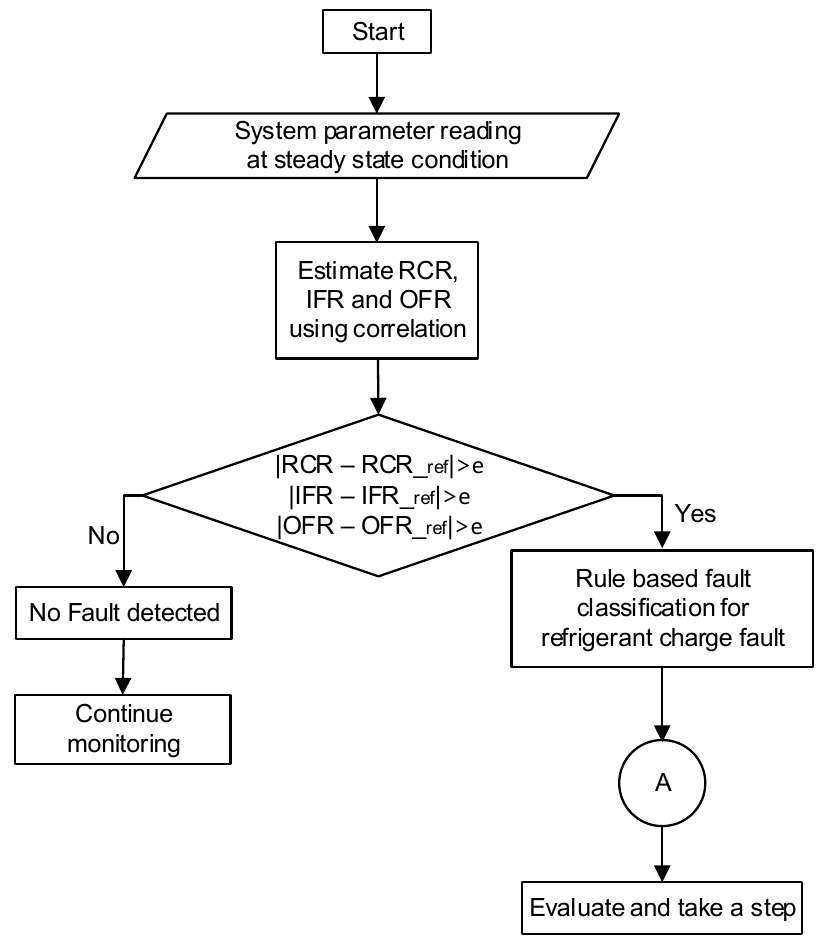
Figure 14. FDD algorithm for simultaneous refrigerant charge and secondary fluid flow rate faults.